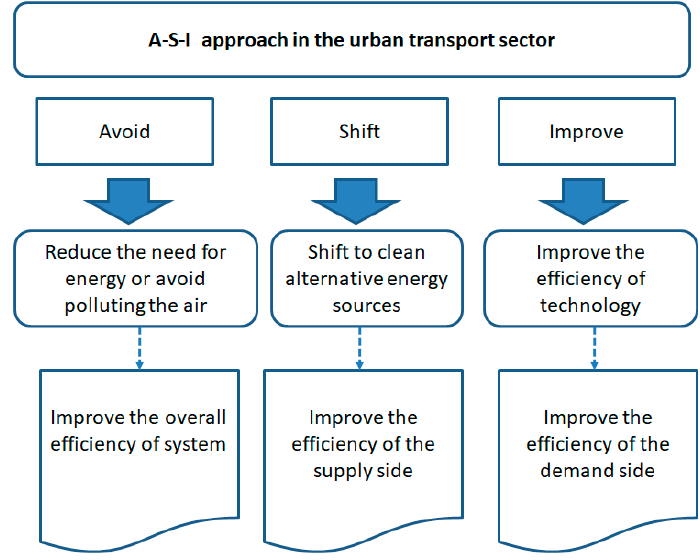
Figure 1. The Avoid-Shift-Improve (A-S-I) framework [37].